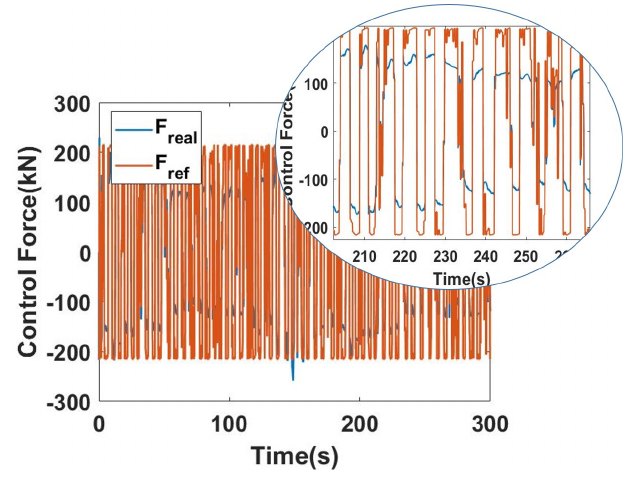
Figure 17. The cylinder force.